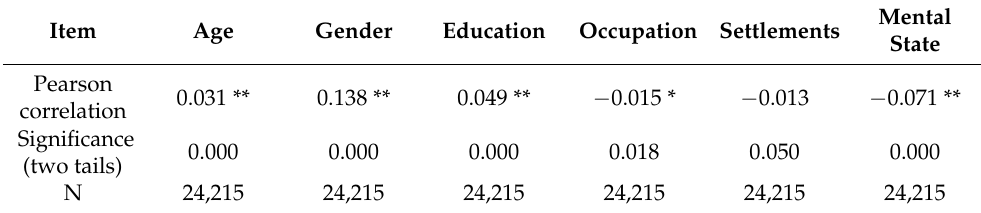
Table 3. Correlation analysis with public environmental cognition.